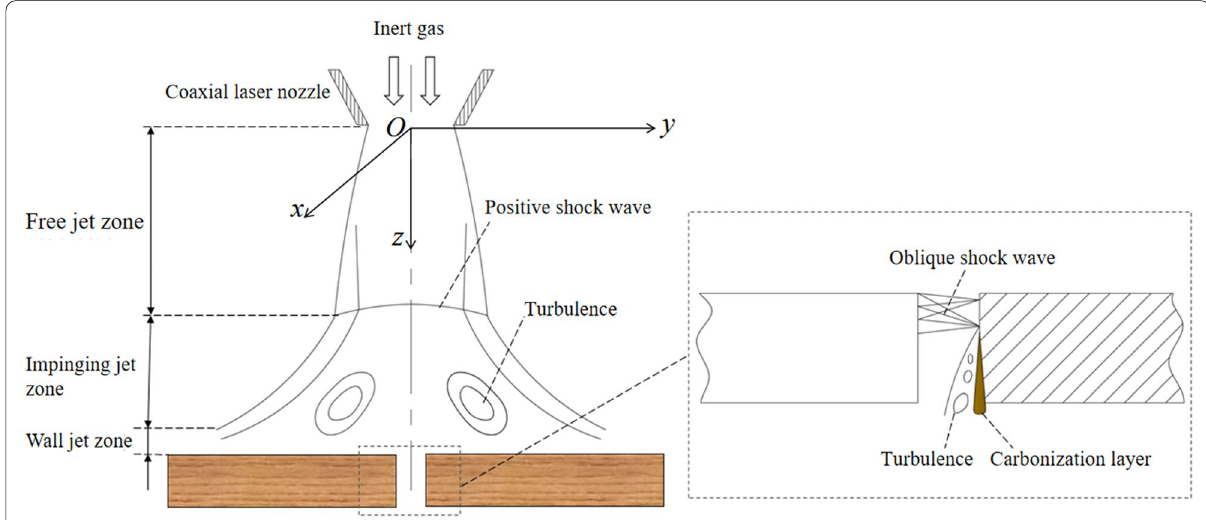
Fig. 1 Gas-assisted jet partition in the cutting